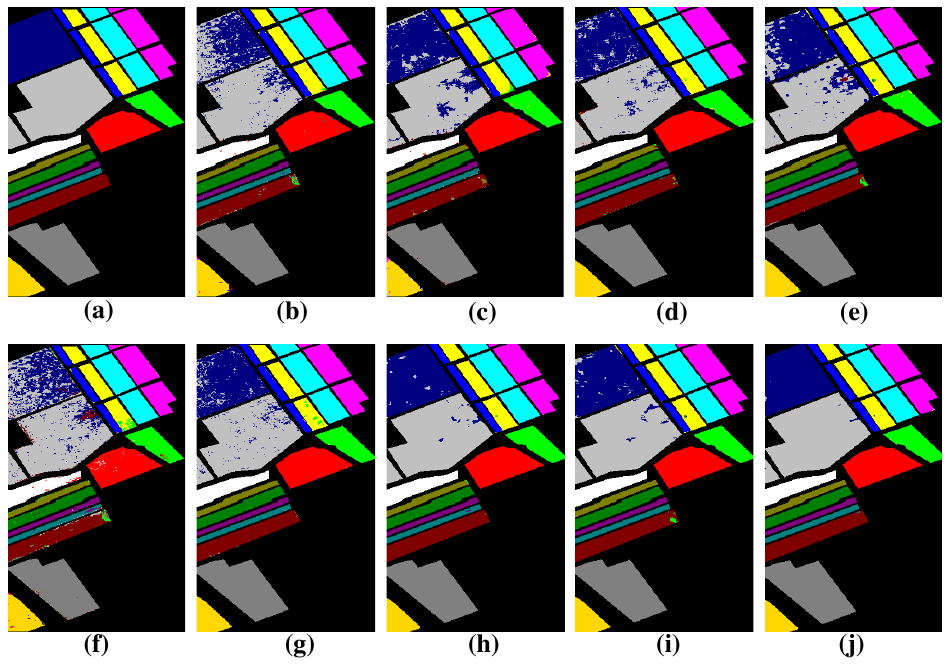
Figure 10. Groundtruth and classification maps with 5% training samples from Salinas dataset. ( a ) Groundtruth; ( b ) SVM; ( c ) EMP-SVM; ( d ) SAE-LR; ( e ) CNN-MLR; ( f ) LSTM; ( g ) MCNN;